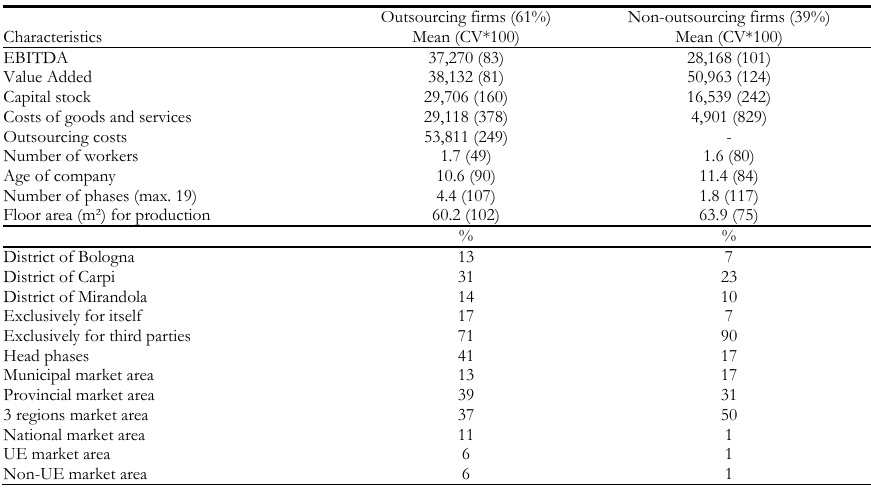
Characteristics of firms with no